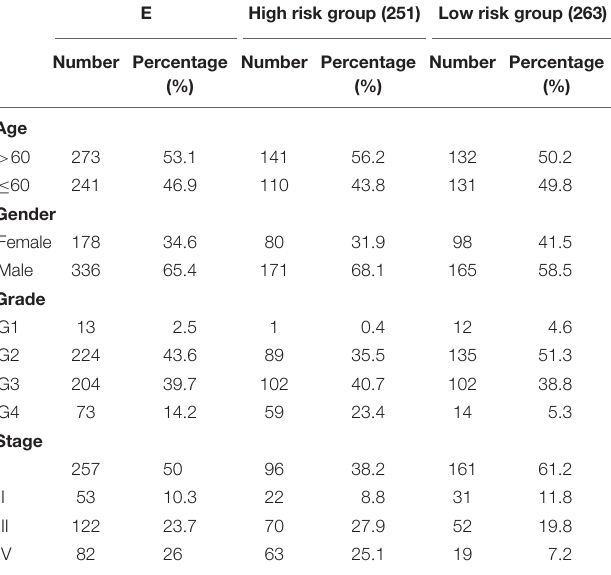
TABLE 1 | Clinical characteristics of the ccRCC